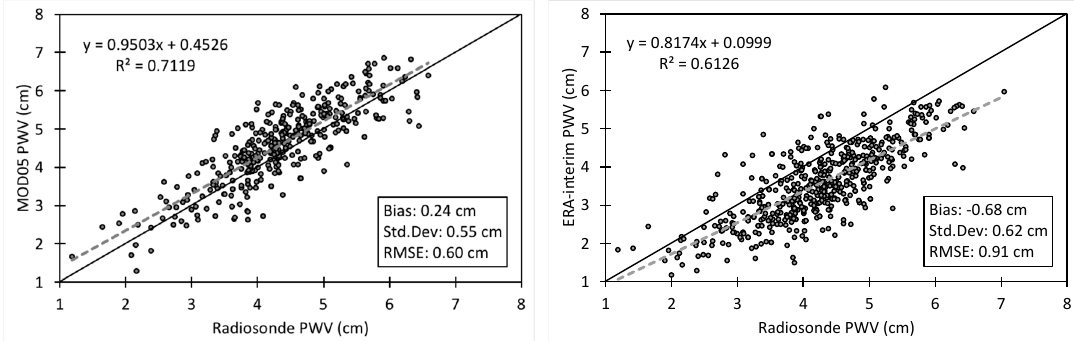
Figure 10. Comparison of PWV values extracted from ( a ) MODIS (MOD05) and ( b ) ERA-interim products against values obtained from in situ radiosonde stations (as described in Table 1). Slope, intercept, and coefficient of determination (R 2 ) are also included, as well as basic statistics such as bias (PWV product minus radiosonde), standard deviation and Root Mean Square Error (RMSE). The continuous line indicates the line 1:1, and the dashed line indicates the linear fit.